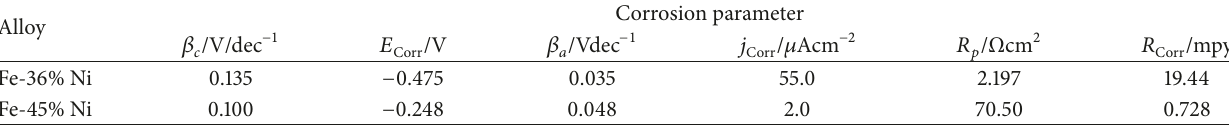
Table 1: Corrosion data obtained from the polarization curves for Fe-36% Ni and Fe-45% Ni in 1 M HCl solutions.